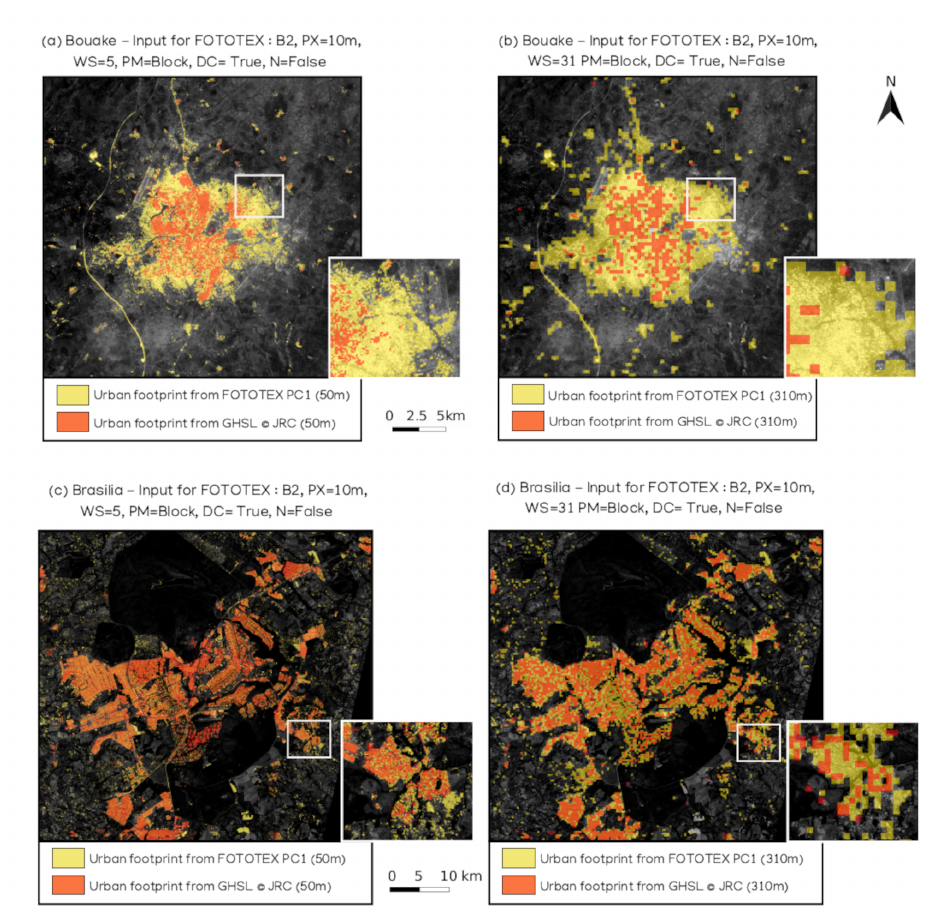
Figure 7. Comparison of urban footprints extracted from Sentinel 2 images on Bouake and Brasilia with FOTOTEX with the Global Human Settlement Layer (GHSL) product from JRC (© European Union) over different window sizes, ( a ) urban footprints on Bouake window size = 5 pixels, ( b ) urban footprints on Bouake window size = 31 pixels, ( c ) urban footprints on Brasilia window size = 5 pixels, ( d ) urban footprints on Brasilia window size = 31 pixels, Sentinel 2 Background © ESA (PX = pixel size, WS = window size, PM = partitioning method, DC = DC component, N =